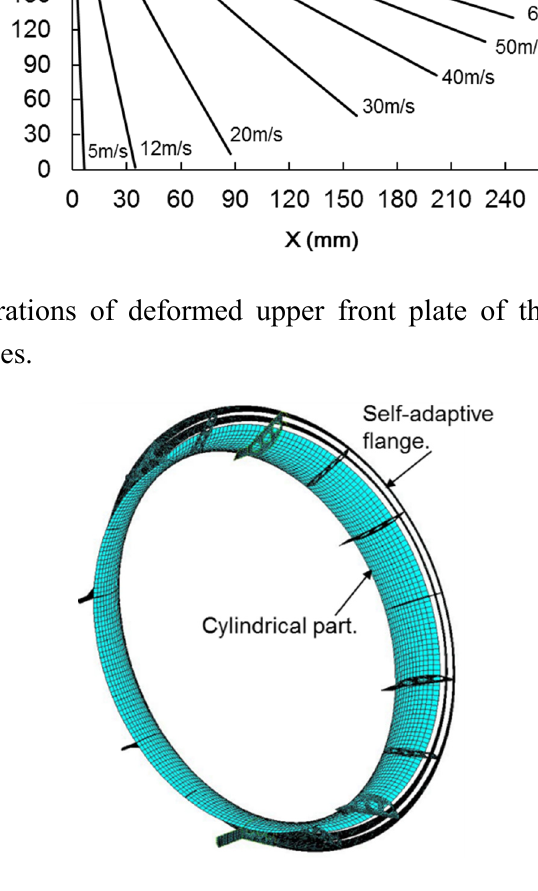
Figure 18. Full image of the diffuser with a self-adaptive flange at 60